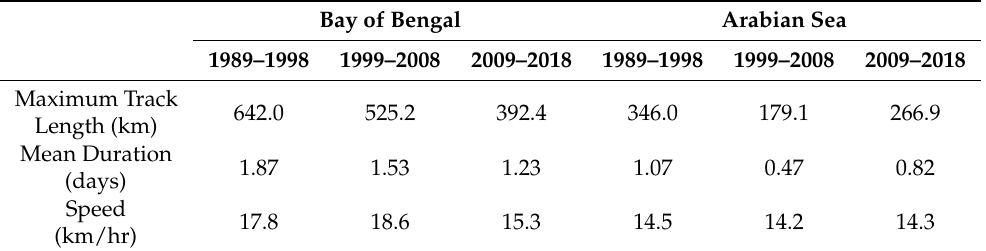
Table 1. Mean inland track length (km), duration (days), and speed (km/hr) by decade for the Bay of Bengal and the Arabian Sea.